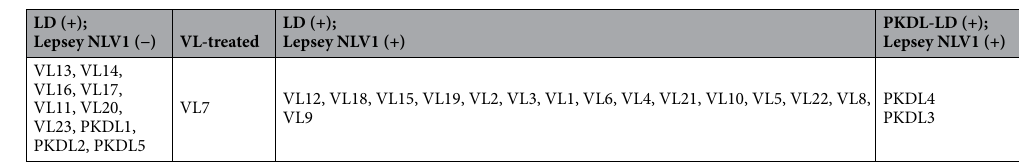
Table 2. List of serum samples used in IL-18